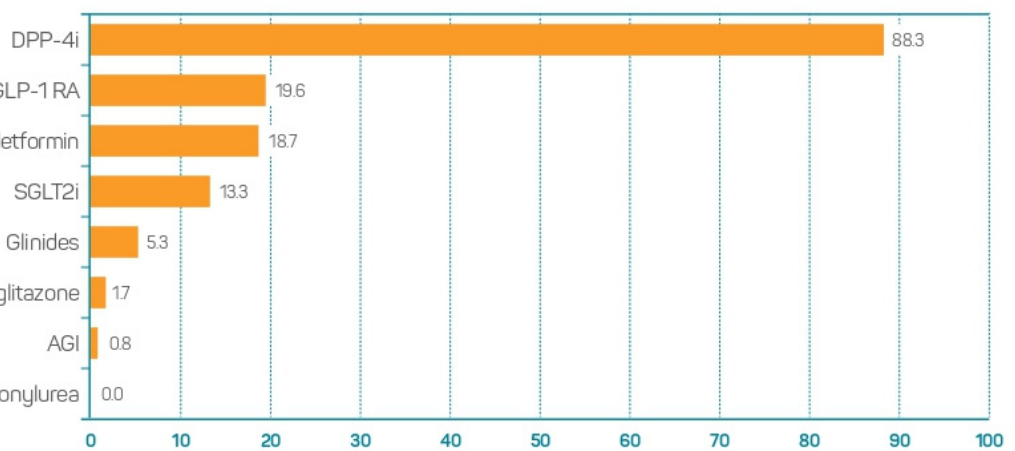
Figure 5. Opinion on pharmacological classes to be maintained in patients with known T2DM admit- ted to hospital due to COVID-19 and requiring corticosteroids. AGI: Alpha-glucosidase inhibitors; DPP-4i, Dipeptidyl peptidase 4 inhibitors; GLP-1 RA, Glucagon-like peptide 1 receptor agonists; SGLT2i, Sodium-glucose transport protein 2 inhibitors.